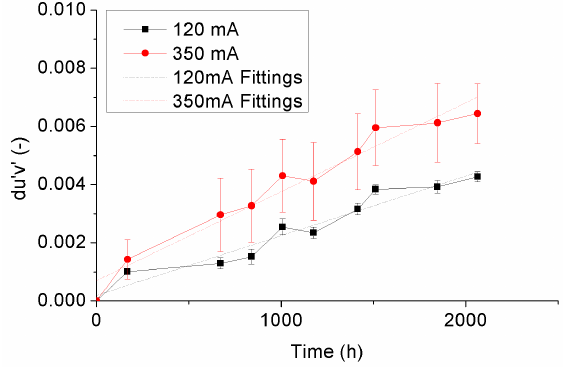
Figure 13. Color shift of the 4000 °K samples.